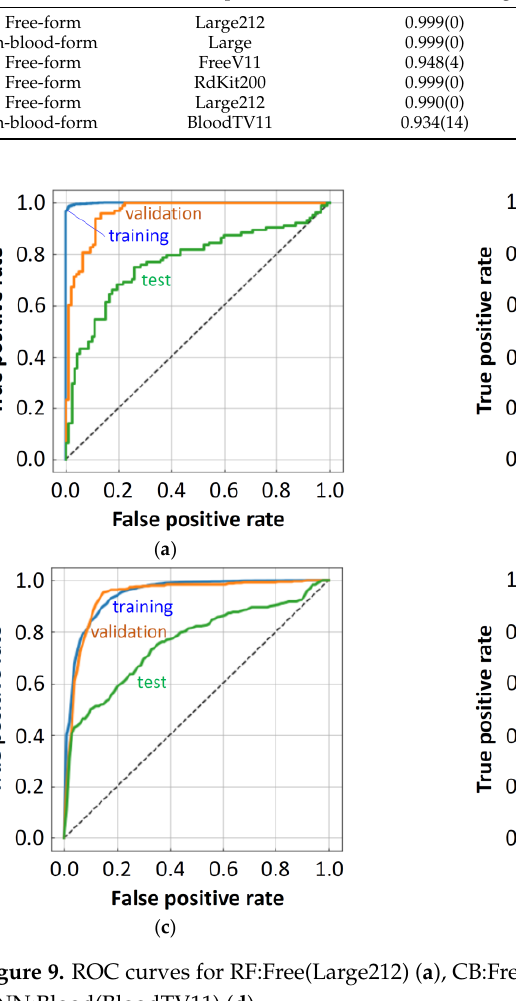
Figure 10. ROC-AUC scores of the top six prediction results and ensemble results.